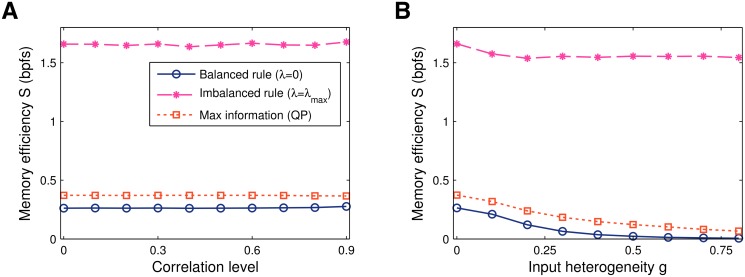
Memory efficiency vs input correlations.
A. In case the mean input remains homogeneous, the three learning algorithms considered — balanced (λ = 0), maximally-imbalanced (λ = λ
max) and maximal-information (QP) — are unaffected by spatial presynaptic activity correlations. B. In case of heterogenous inputs, the balanced rule (λ = 0) and the QP algorithm deteriorate. Imbalanced plasticity performs well, however, as it regularises the high-activity synapses while ignoring the remaining ones. As a result the memory efficiency of the maximally-imbalanced solution is approximately constant. Data obtained by averaging a hundred independent simulations at α = 0.1, f = 1/2, and N = 1000 synapses.